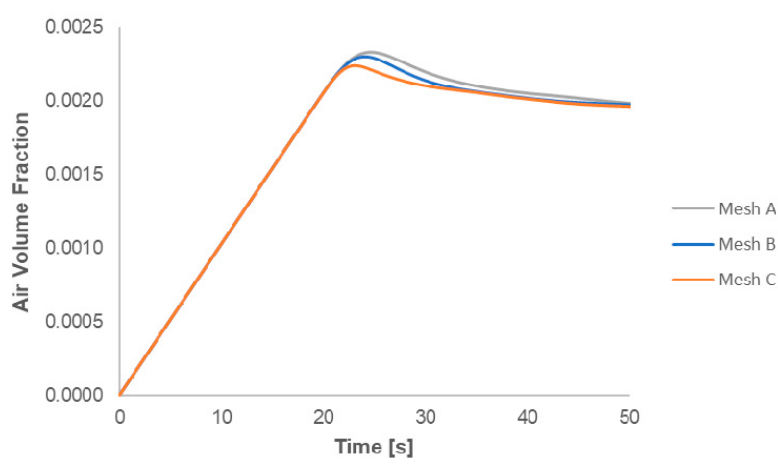
Figure 3. Comparison of Air Volume Fraction.